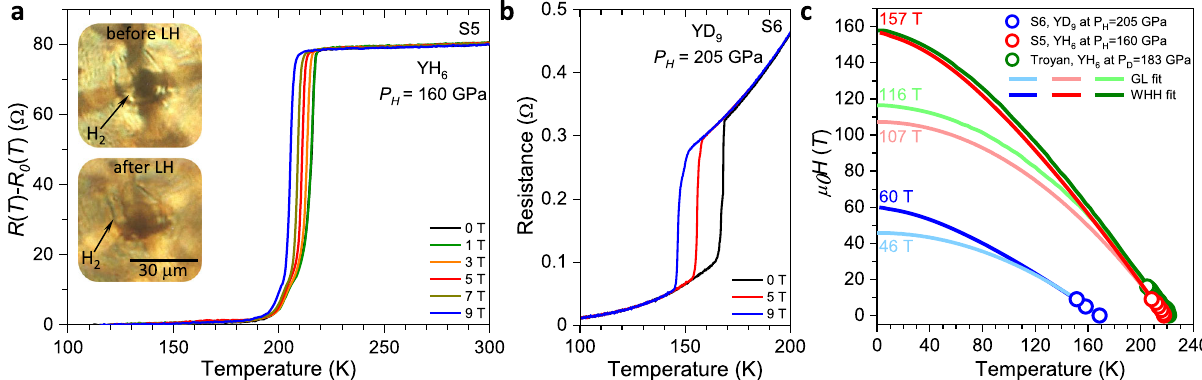
Fig. 5 Temperature dependence of the resistance for the Im-3m YH 6 and P6 3 /mmc YD 9 phases under external magnetic fi eld. a , b DC fi eld measurements for the Im-3m YH 6 phase at P H = 160 GPa in sample 5 (S5) and the P6 3 /mmc YD 9 phase at P H = 205 GPa in sample 6 (S6), respectively. c Fits of the superconducting upper critical fi eld H c2 to the Werthamer – Helfand – Hohenberg (WHH) and Ginzburg – Landau (GL) formalisms. Red and blue circles denote the H c2 s measured for Im-3m YH 6 at P H = 160 GPa and P6 3 /mmc YD 9 phase at P H = 205GPa, respectively. The dark and light curves are the WHH and GL fi ts to the experimental data. Green circles and green curves are the data for Im-3m YH 6 phase at P D = 183 GPa from Troyan et al. 26